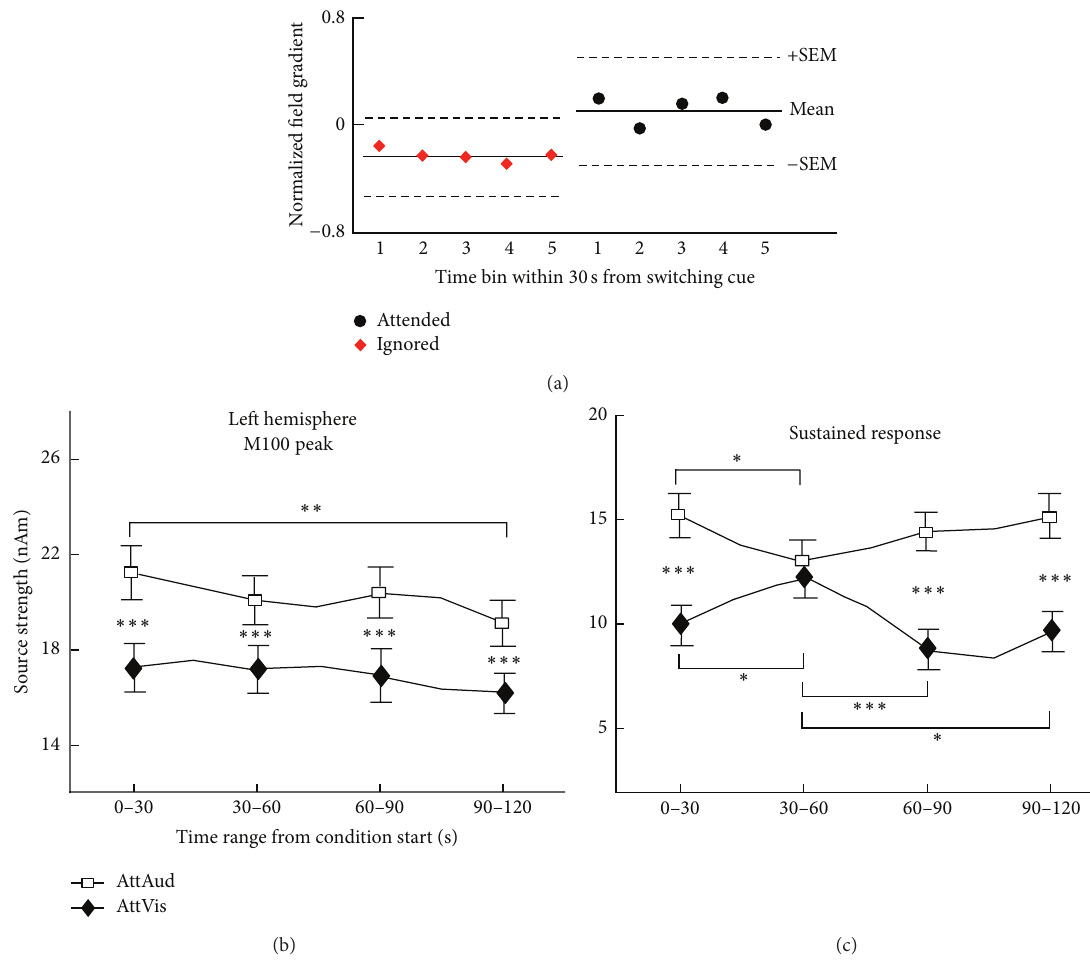
Figure 3: Time course of auditory-cortex short-term plasticity effects that take place during selective-attention. (a) Evolution of selective- attention effects within 30s period that followed task engagement, based on measurement of nonprimary auditory-cortical activity 50–150 from sound onset. The responses were allocated to five consecutive time bins and as can be seen the attention effects are observable already in the first responses (right, time bin 1) after attention switching, suggesting rapid ( ∼ seconds) buildup of the short-term plasticity effects. Conversely, the similarity of response amplitudes to unattended tones across the bins (on the left) suggests that attention-induced short-term plasticityeffectsarewashedoutveryrapidlyfollowingdisengagementofattention.(b)-(c)Transient( ∼ 100 msfromsoundonset)andsustained response ( ∼ 300ms) amplitudes as a function of time from the onset of attentional condition. Note again how the ∼ 100ms response attention effect does not show any dynamics, but the sustained response shows a significant interaction effect with attention and time range from the onset of the attention shift, suggesting that the short-term plasticity that modulates processing at ∼ 300 ms from sound onset builds up much more gradually than the effects seen in activity that is elicited ∼ 100ms from sound onset. ((a) and ((b)-(c)) are adapted with permission from [88, 93],